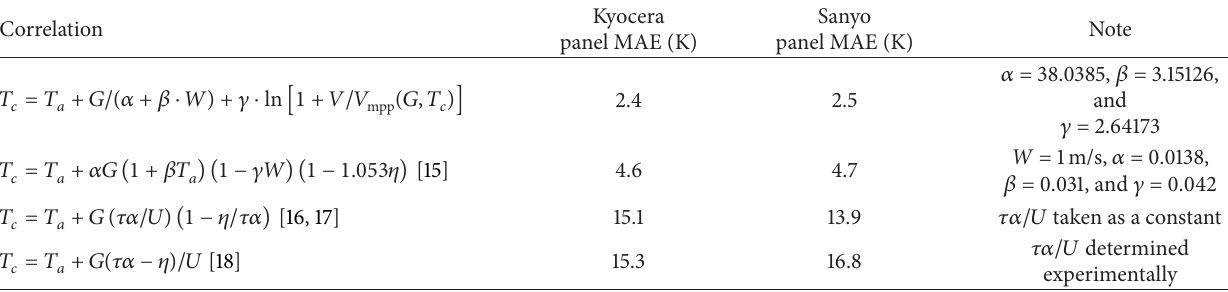
Table 4: MAE results for different 𝑇 𝑐